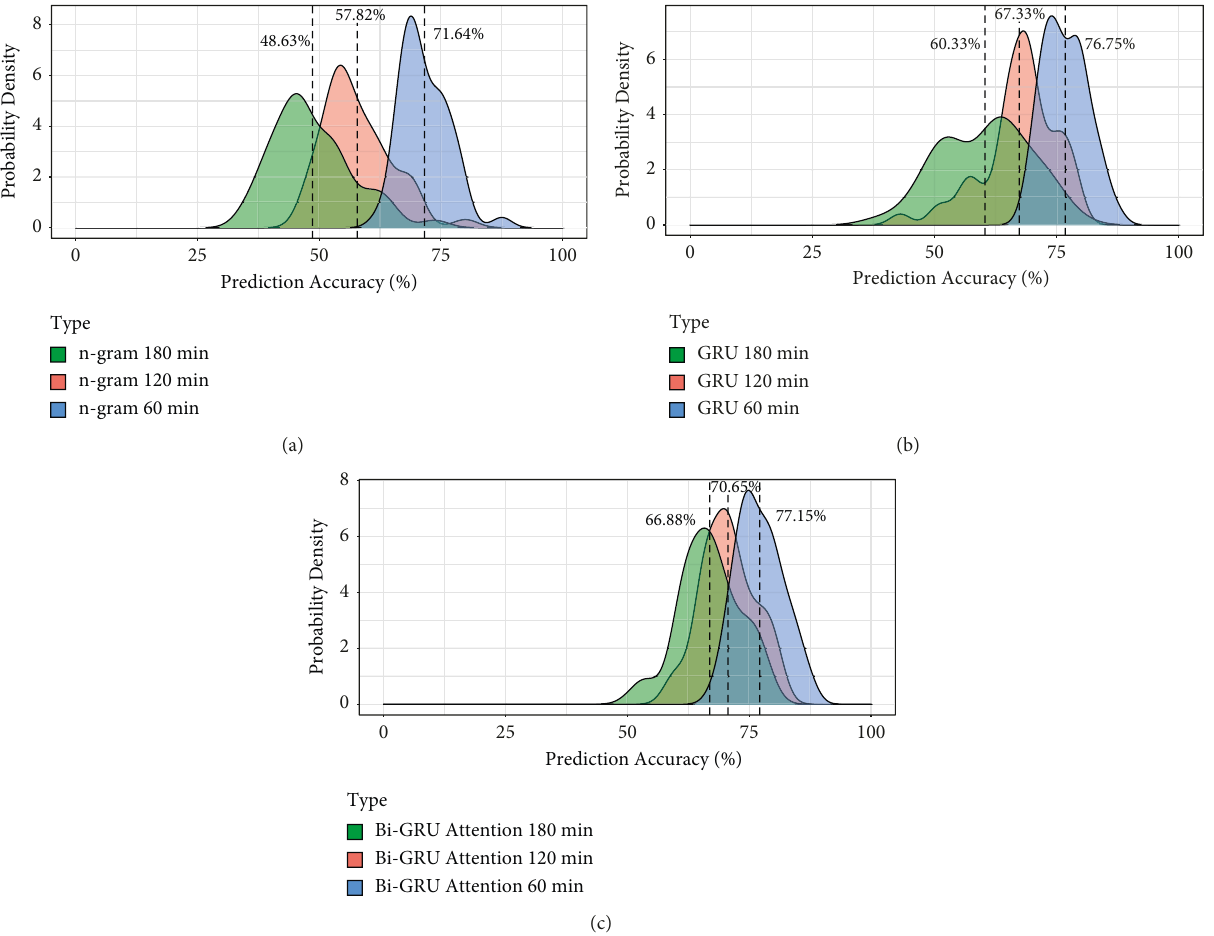
Figure 8: The performance of Bi-GRU-Attention compared with baseline models. (a) n -gram prediction accuracy. (b) GRU prediction accuracy. (c) Bi-GRU-Attention prediction